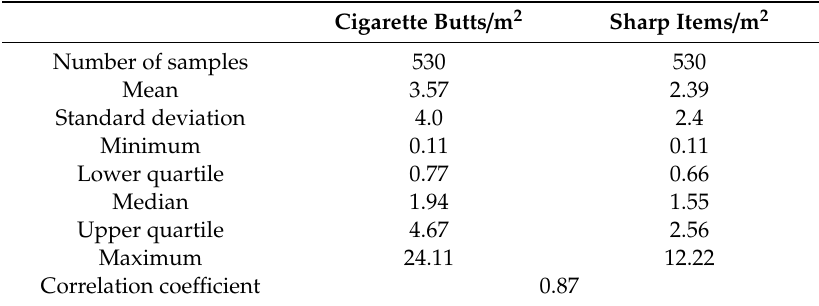
Table 1. Main statistics of sampling data.